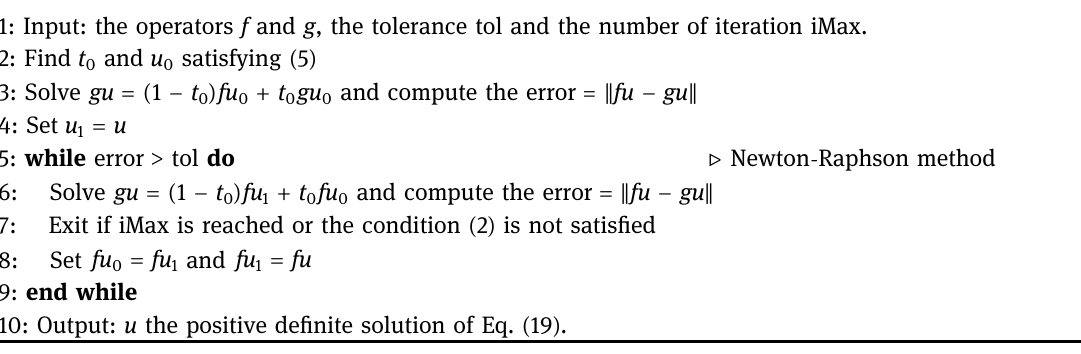
Algorithm 1. Case of the matrix Eq. ( 19 ) .